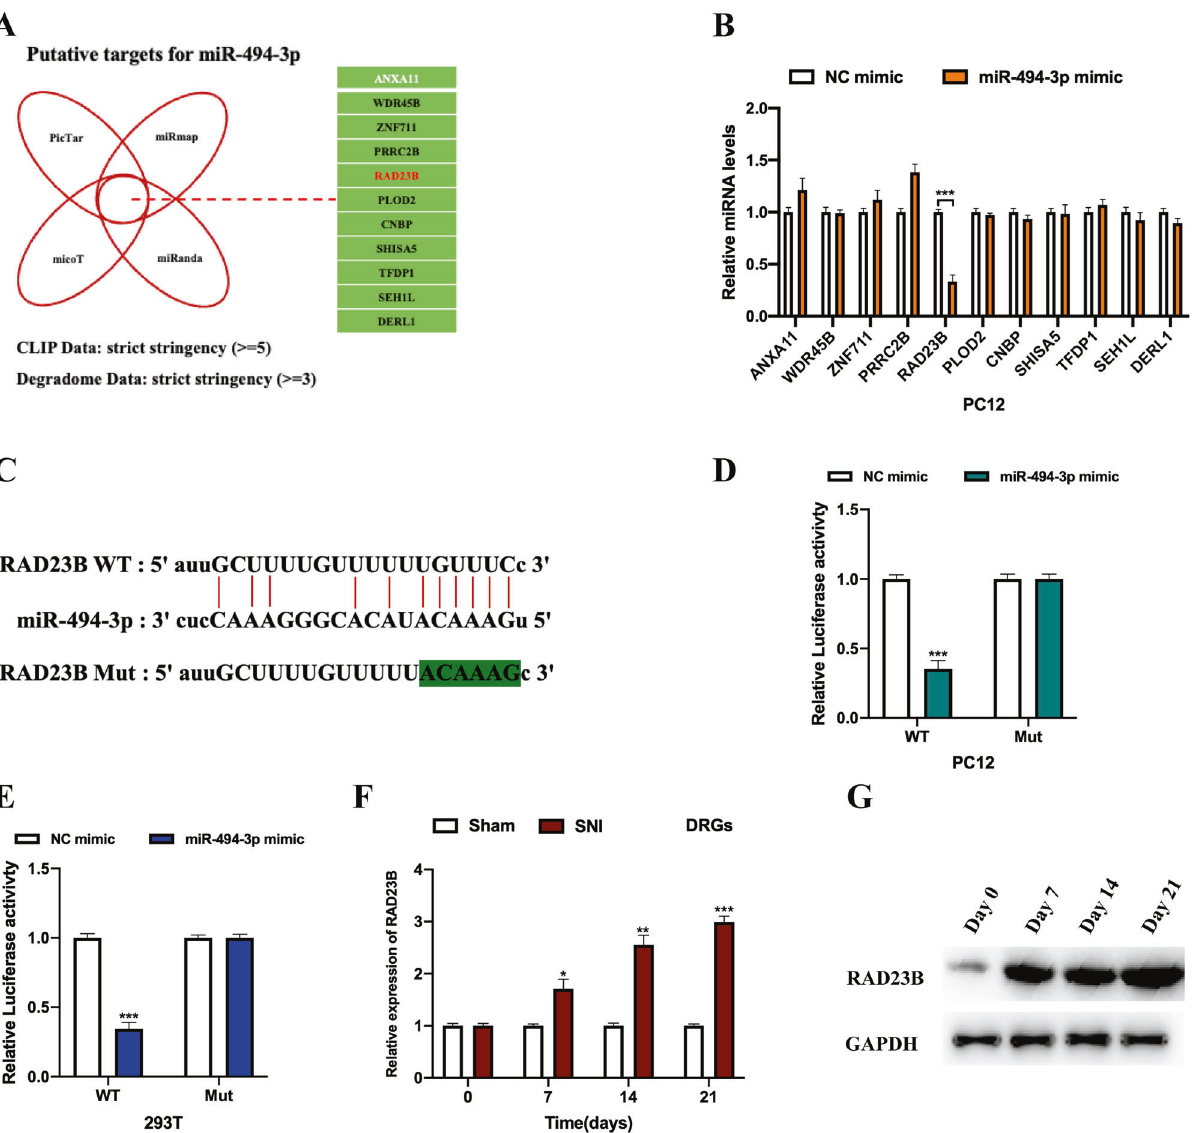
Fig. 6 MiR-494-3p directly targets RAD23B. A The intersection results of the bioinformatics analysis of miR-494-3p potential targets are illustrated in a scheme. B Relative expression levels of putative mRNA targets in miR-494-3p overexpressed PC12 cells were measured by qRT- PCR. C Predicted binding sequences between RAD23B and miR-494-3p are shown. The binding possibility between RAD23B and miR-494-3p was veri fi ed by a luciferase reporter gene assay in microglial cells ( D ) and 293 T cells ( E ). The relative expression of RAD23B in the DRGs isolated from SNI or Sham rats at the indicated time points was assessed by qRT-PCR ( F ) and western blot ( G ). Experimental data are presented as mean ± SD. * P < 0.05, ** P < 0.01, *** P <